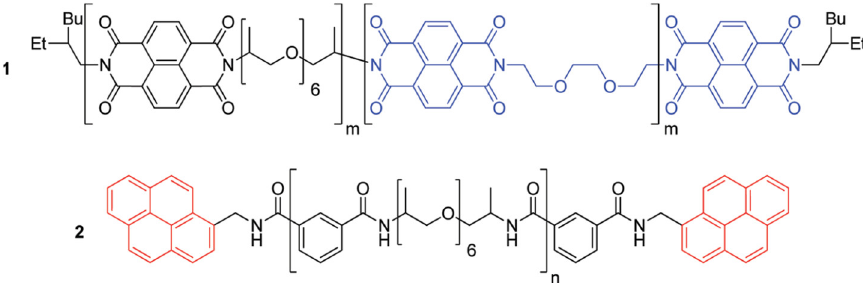
Scheme 2. Molecular structure of a 1+2 self-healing polymer blend. Reprinted with permission from [55]. Copyright (2012) American Chemical Society.